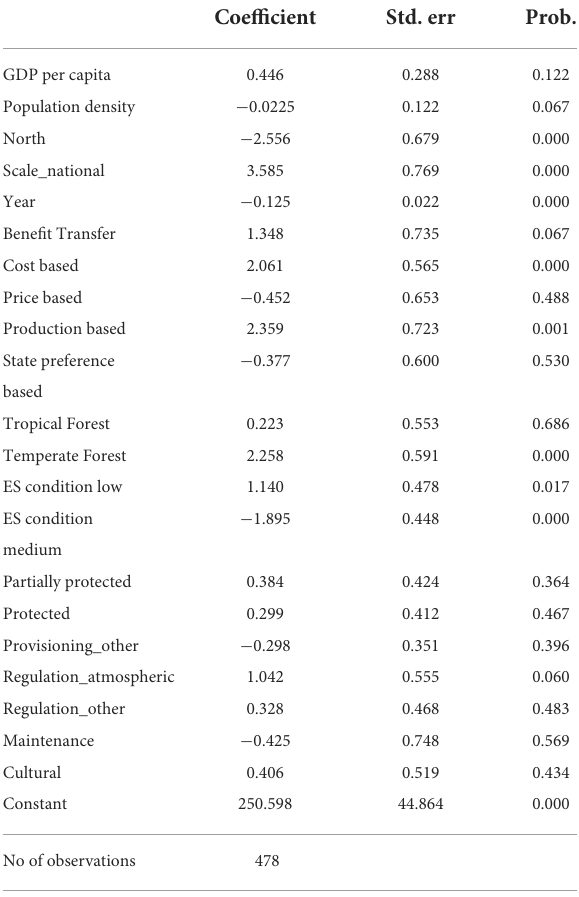
TABLE 2 Estimated results of the model with robust standard errors. Coefficient Std. err